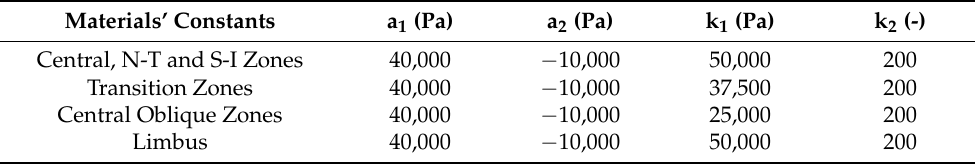
Table 1. Materials’ constants for anisotropic hyperelastic materials definition. Materials’